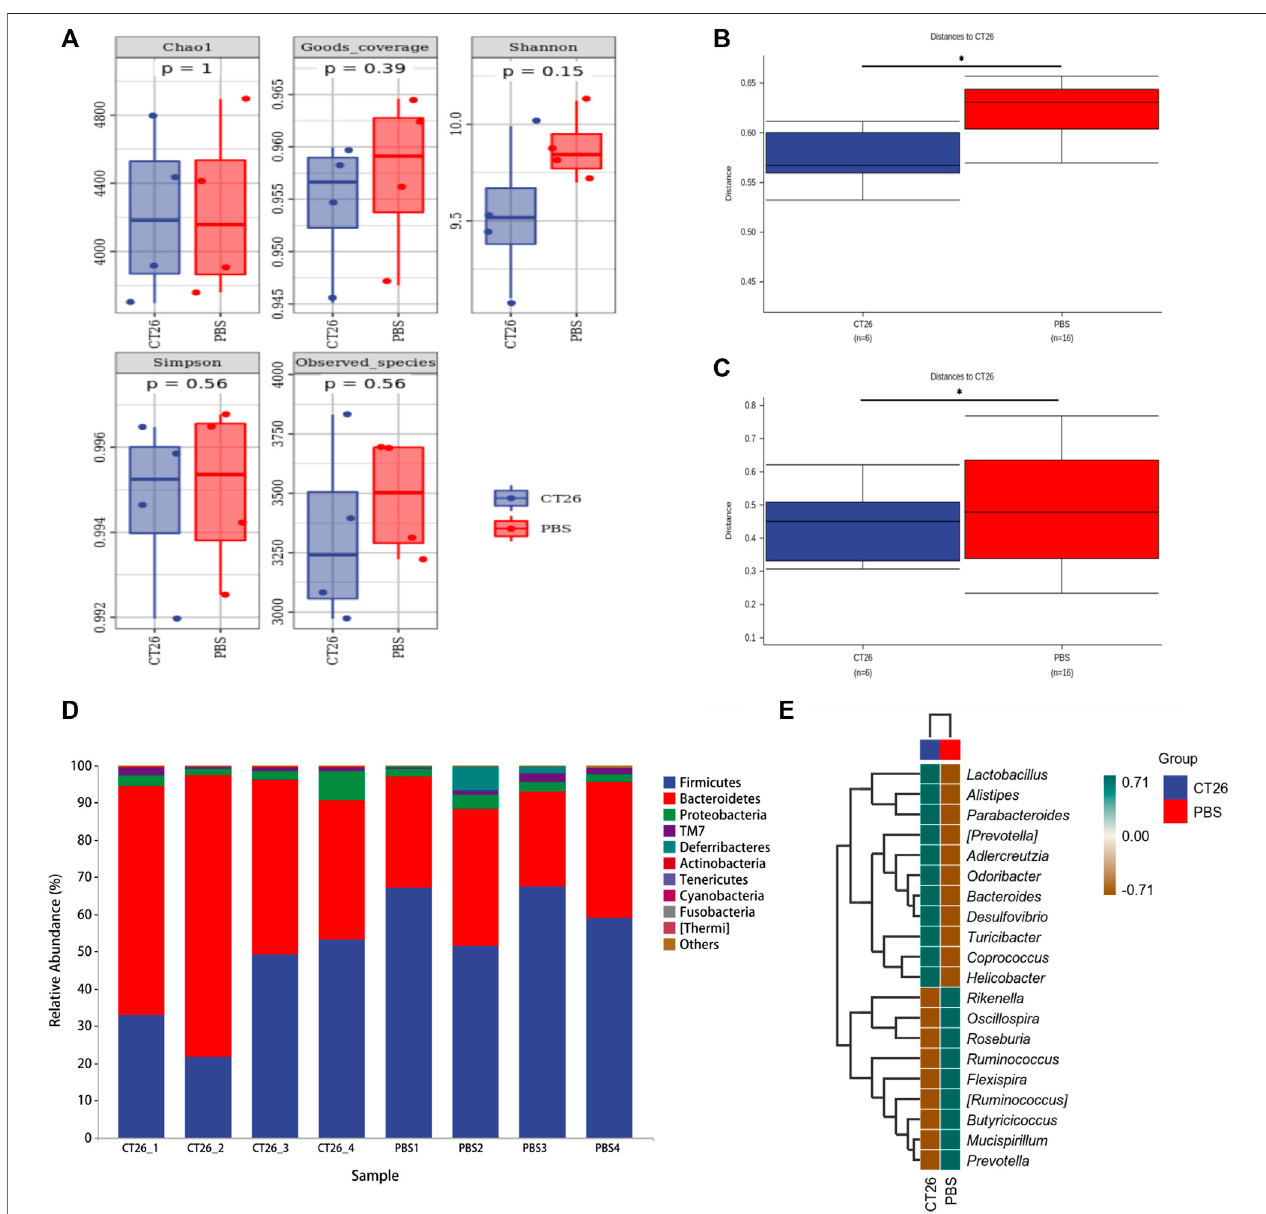
FIGURE 2 | GM differences between the CT26 group and the PBS group. (A) Diversity index analysis (Chao1, Good ’ s coverage, Shannon, Simpson, and Observed species) between the CT26 group and the PBS group. (B) Differences in unweighted UniFrac distance between the CT26 group and the PBS group. (C) Differences in weighted UniFrac distance between the CT26 group and the PBS group. (D) Total gut bacterial relative abundance at the taxonomic rank of phylum. (E) Heat map of species composition of the gut microbiota in the CT26 group and the PBS group at the genus level. * represents p <